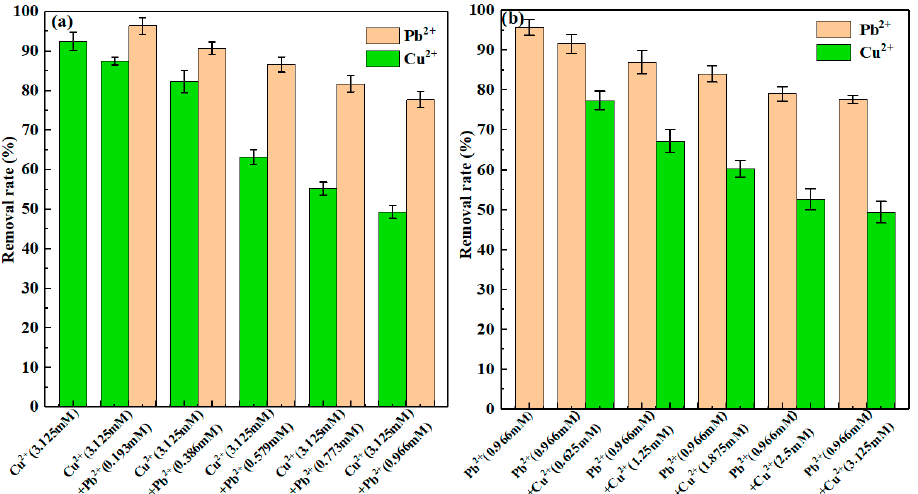
Figure 9. Removal rate of competitive adsorption of Cu(II)and Pb(II) onto CLB with 3.125 mM Cu(II) ( a ) and 0.966 mM Pb(II) ( b ) as background solution, respectively, at pH =